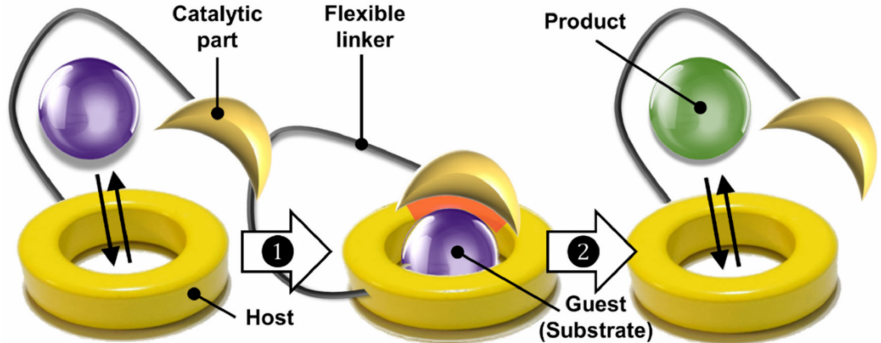
Figure 3. The general principle of “chemzymes” (1 = formation of the “chemzyme”–substrate complex and 2 = catalytic